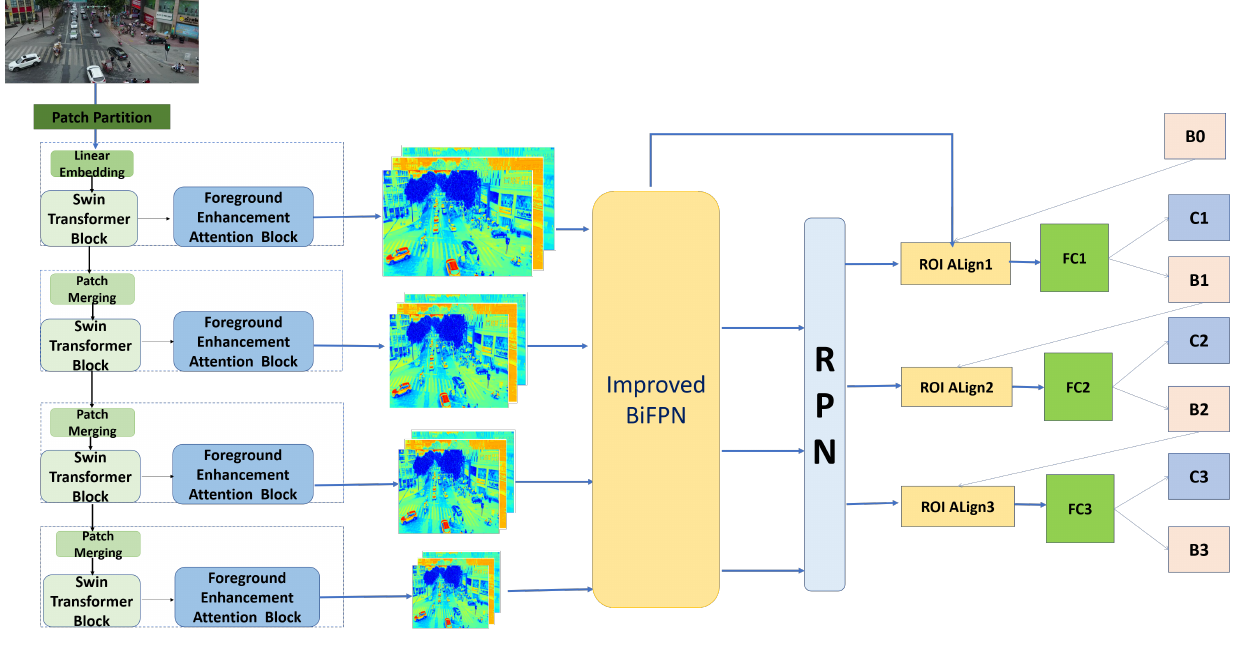
Figure 2. Architecture of